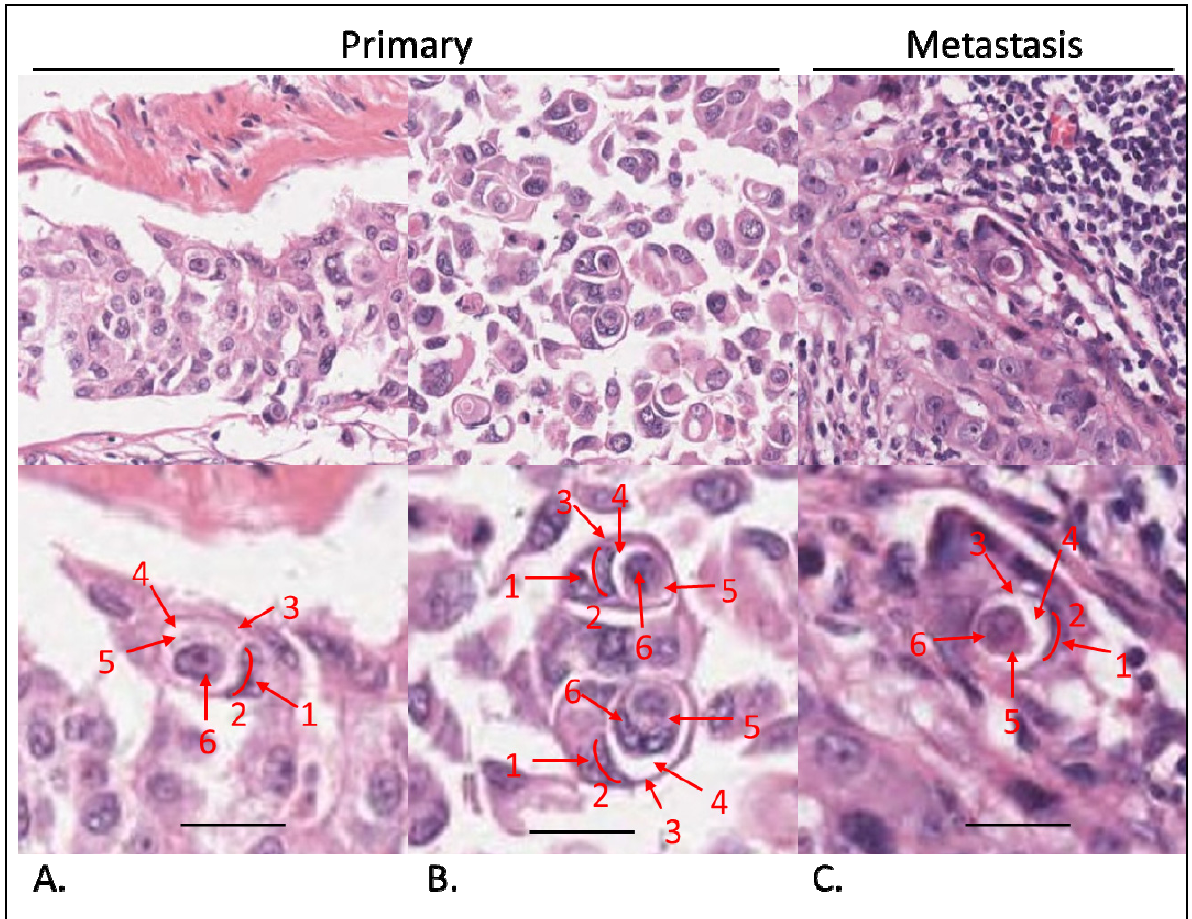
Figure 1. Evaluation of entotic structures in the cohort. Tissue samples stained with hematoxylin and eosin. ( A , B ) Entoses identified in primary tumors. Top panels observed under a 40 × microscope objective; bottom panels digitally magnified to demonstrate Mackay’s criteria: (1) nucleus of the outer cell; (2) semilunar shape of the outer cell nucleus; (3) outer cell cytoplasm; (4) entotic vacuole; (5) inner cell cytoplasm; (6) inner cell nucleus. At least 4 out of 6 criteria have to be visible to classify a structure as an entotic figure. ( C ) Entosis in a lymph node metastasis. Top panel: 40 × microscope objective; bottom panel is magnified and structures are marked as in ( A , B ). Scalebar: 15 μ m.